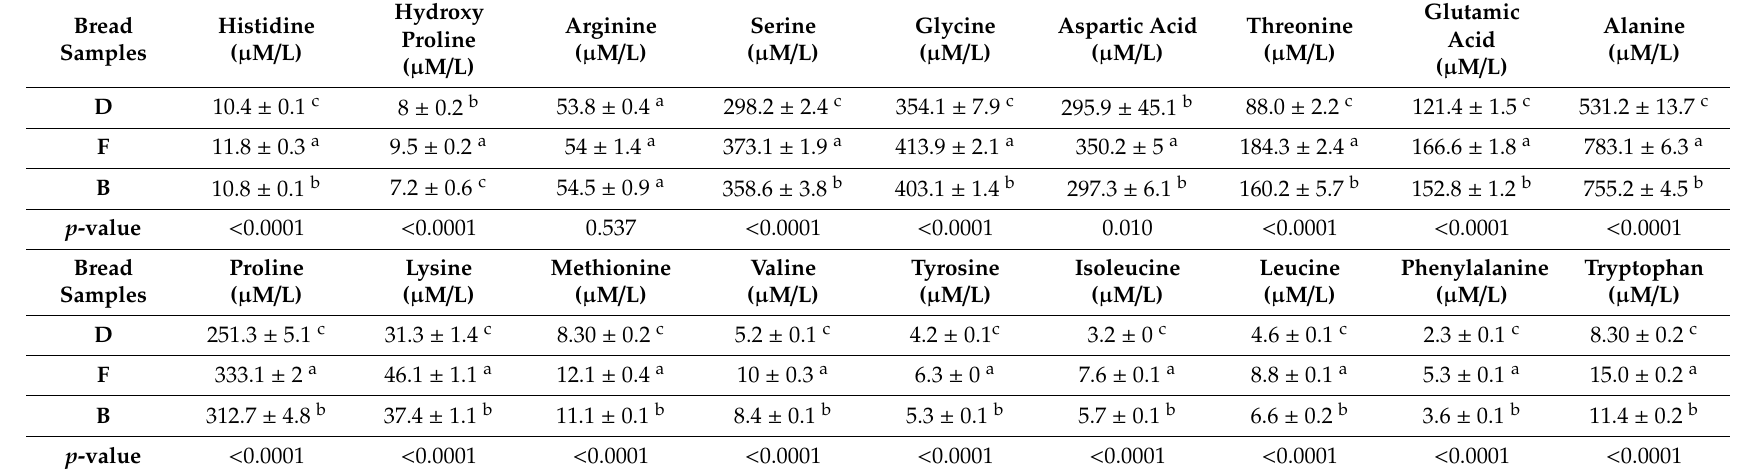
Table 4. Amino acids content of selected sourdough breads (D, B and F) fermented without yeast for 24